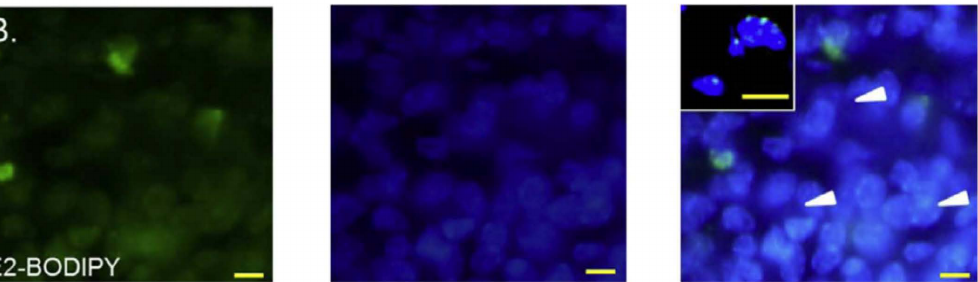
Figure 15. Subcellular localization of E2-BODIPY 73 in uteri of non-ovariectomized mice. The first image in each row is the emission fluorescence at 488 nm. The second image in each row is the image of the Hoechst 33,342 nuclear stain that has excitation/emission maxima at 350/461 nm when bound to DNA. The third image is a merged photo of the first two images. Row B shows intranuclear localization of E2-BODIPY. Adapted from